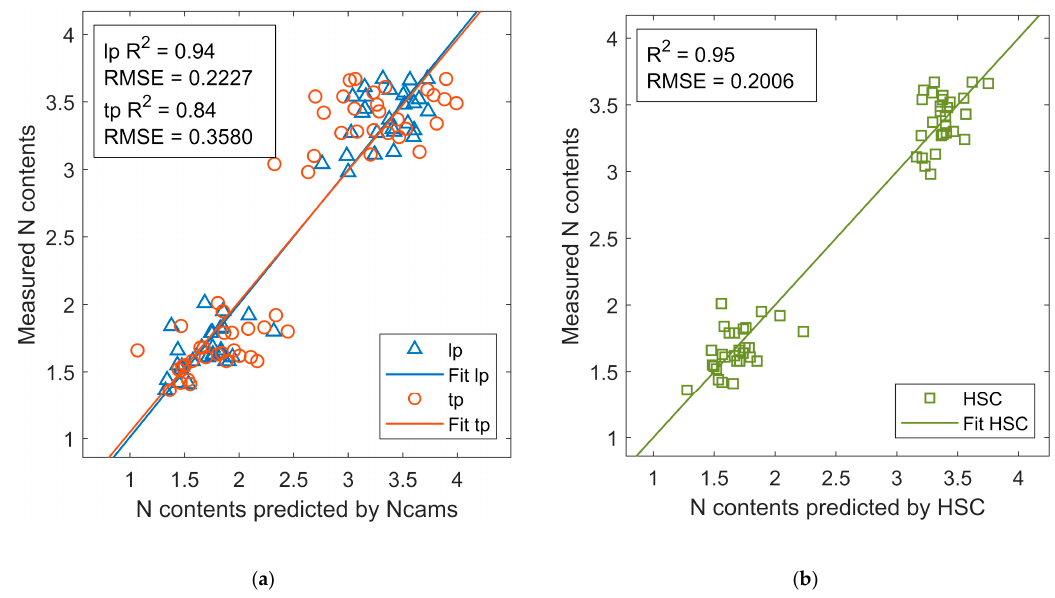
Figure 8. The performances of Ncams on estimating nitrogen (N) contents with ( a ) Ncams and ( b ) HSC. lp, Ncam lp; tp, Ncam tp.